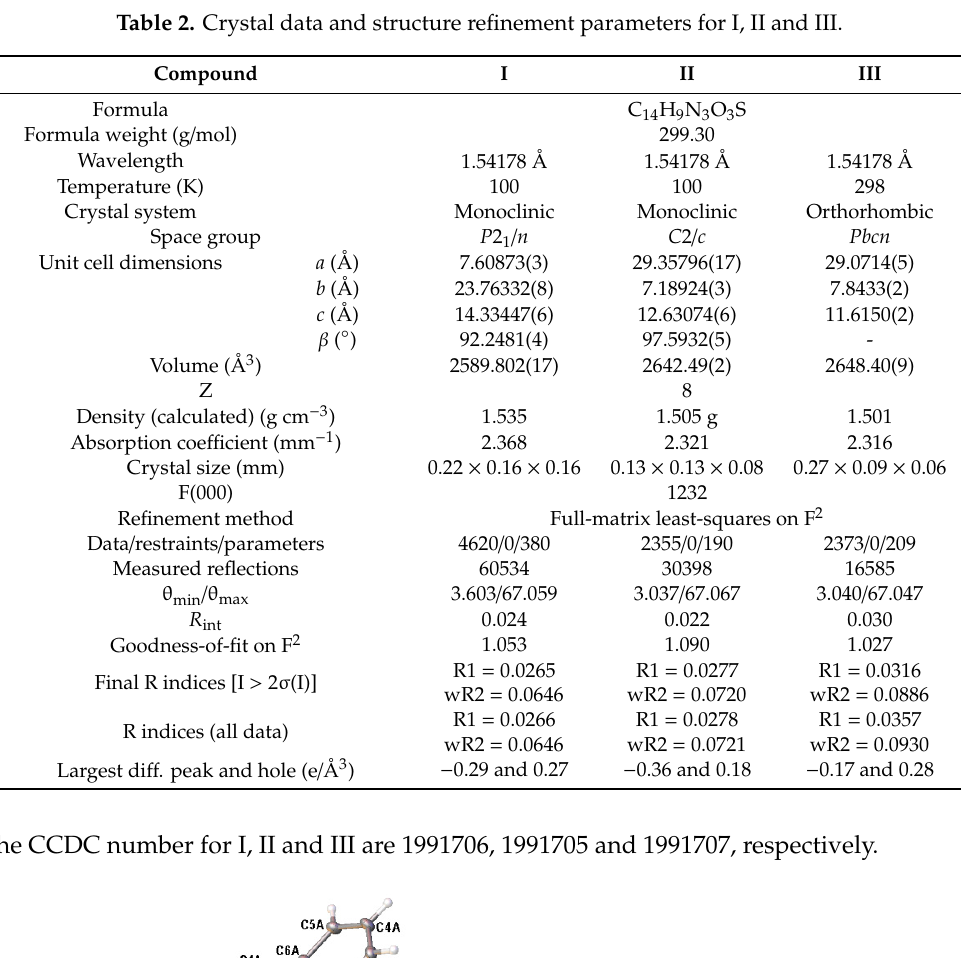
Table 2. Crystal data and structure refinement parameters for I, II and III.